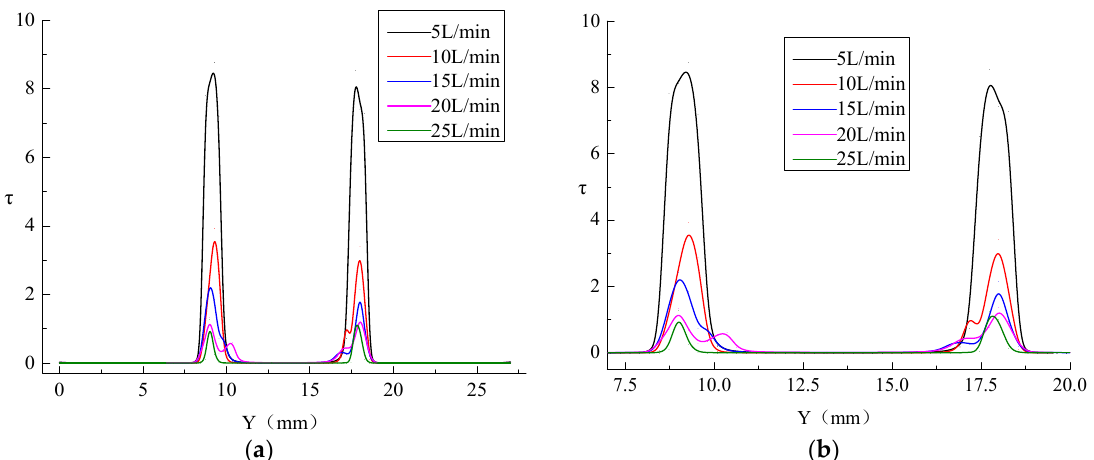
Figure 5. Coefficient distribution of pressure pulsation at the leading edge monitoring lines under different flow conditions at 80° opening degree. ( a ) The complete view. ( b ) The local enlarged view.